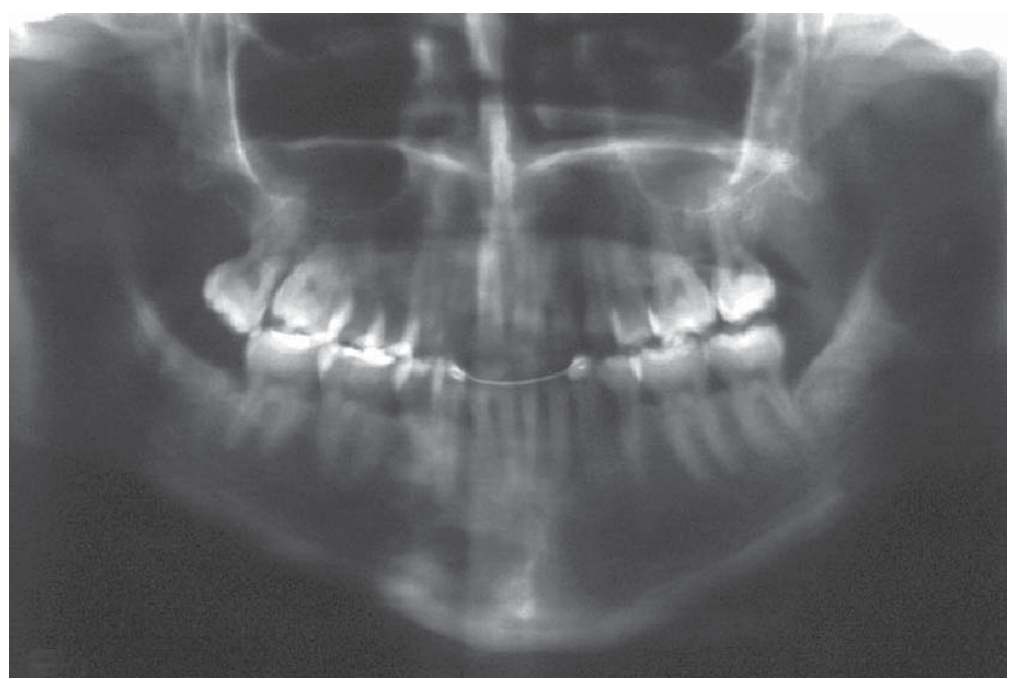
FIGURE 7- Posttreatment study models